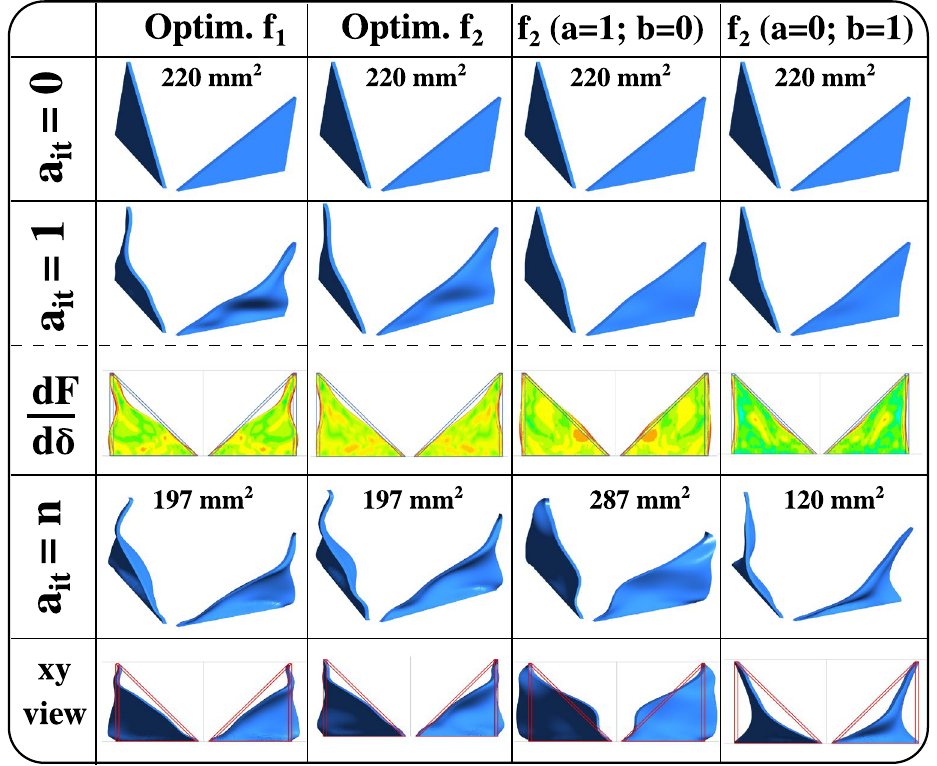
Figure 2. Optimization results showing designs evolution as function of the adjoint iterations a it in the ABO algorithm (Fig. 10). The RVG shape change showing an example of the sensitivity dF d δ maps after the first adjoint iteration a it = 1 . Comparisons between the DWP initial base design at a it = 0 and the three adjoint-based optimum designs obtained with a TPF Morph objective f 1 , extreme objective f 2 ( a = 1 ; b = 0 ) and extreme objective f 2 ( a = 0 ; b = 1 ) . The frontal area of RVG in the xy-plane is shown in mm and the end at a it = n of the ABO iterations (see the algorithm in Fig. 10).